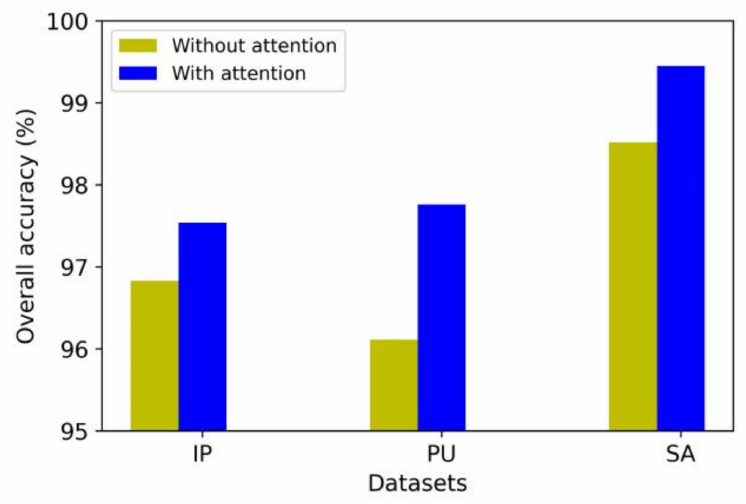
Figure 11. Effectiveness of the attention mechanism.